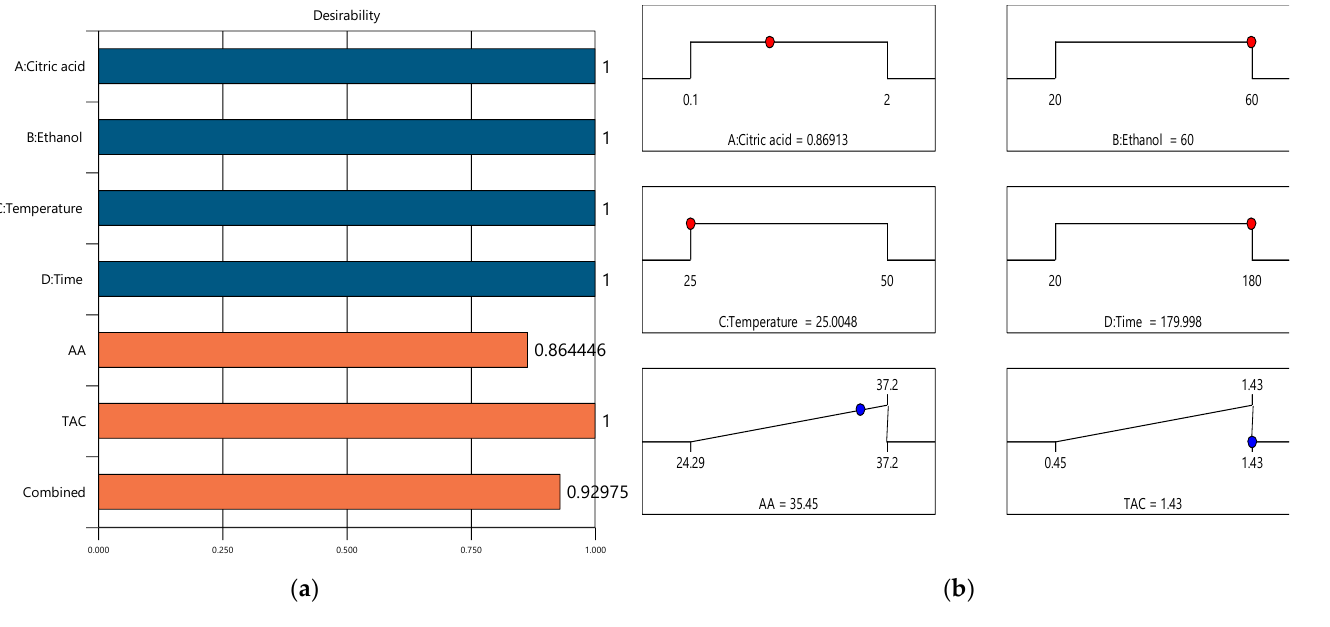
Figure 3. Optimization desirability bar chart ( a ) and ramps ( b ). Table 4. Validation of the mathematical model. Table 4. Validation of the mathematical